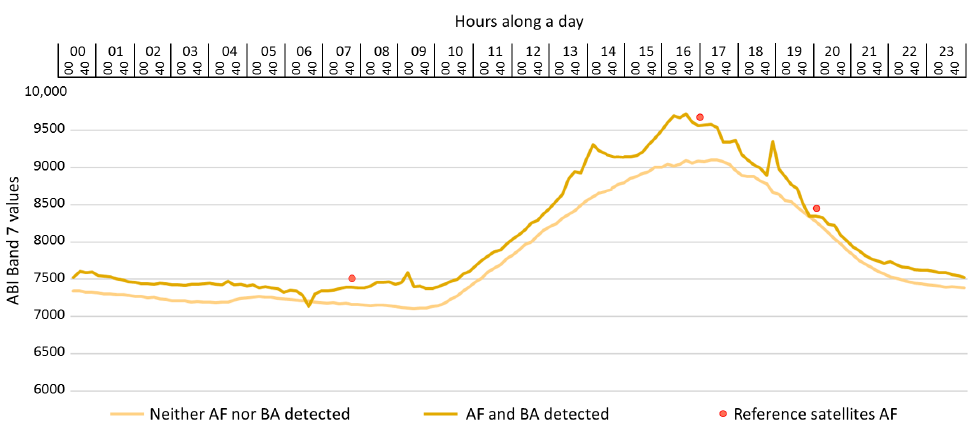
Figure 2. ABI Band 7 values for 2 different pixel locations on a given day with and without the detection of AF and BA. AF: Active Fire; BA: Burned